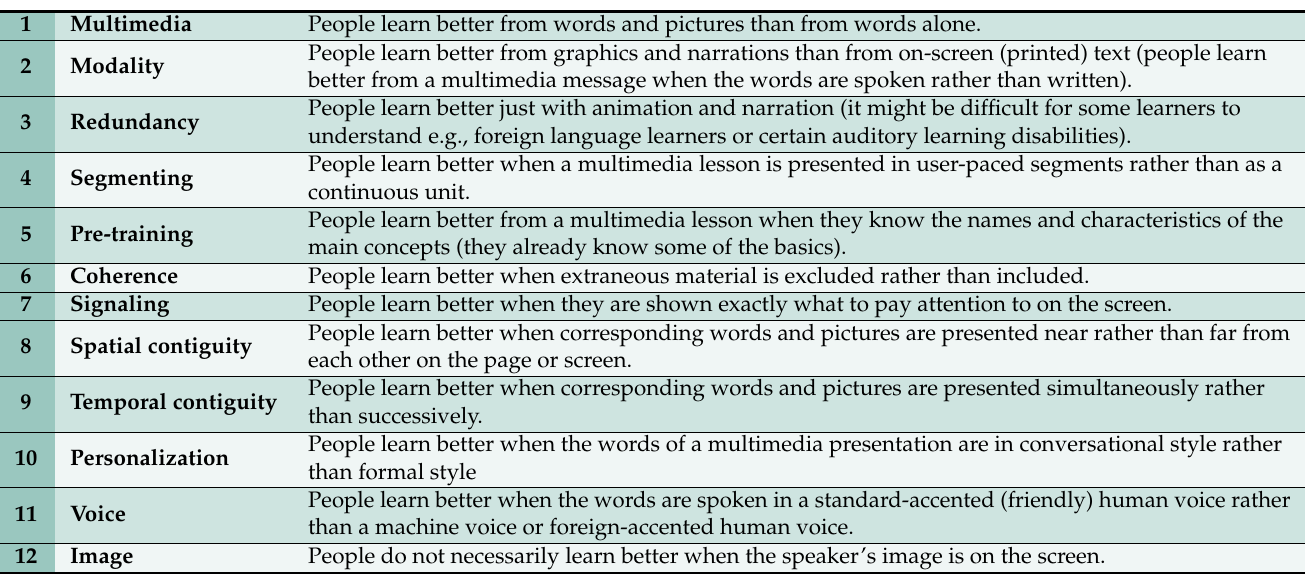
Table 2. Basic principles of Multimedia Learning.